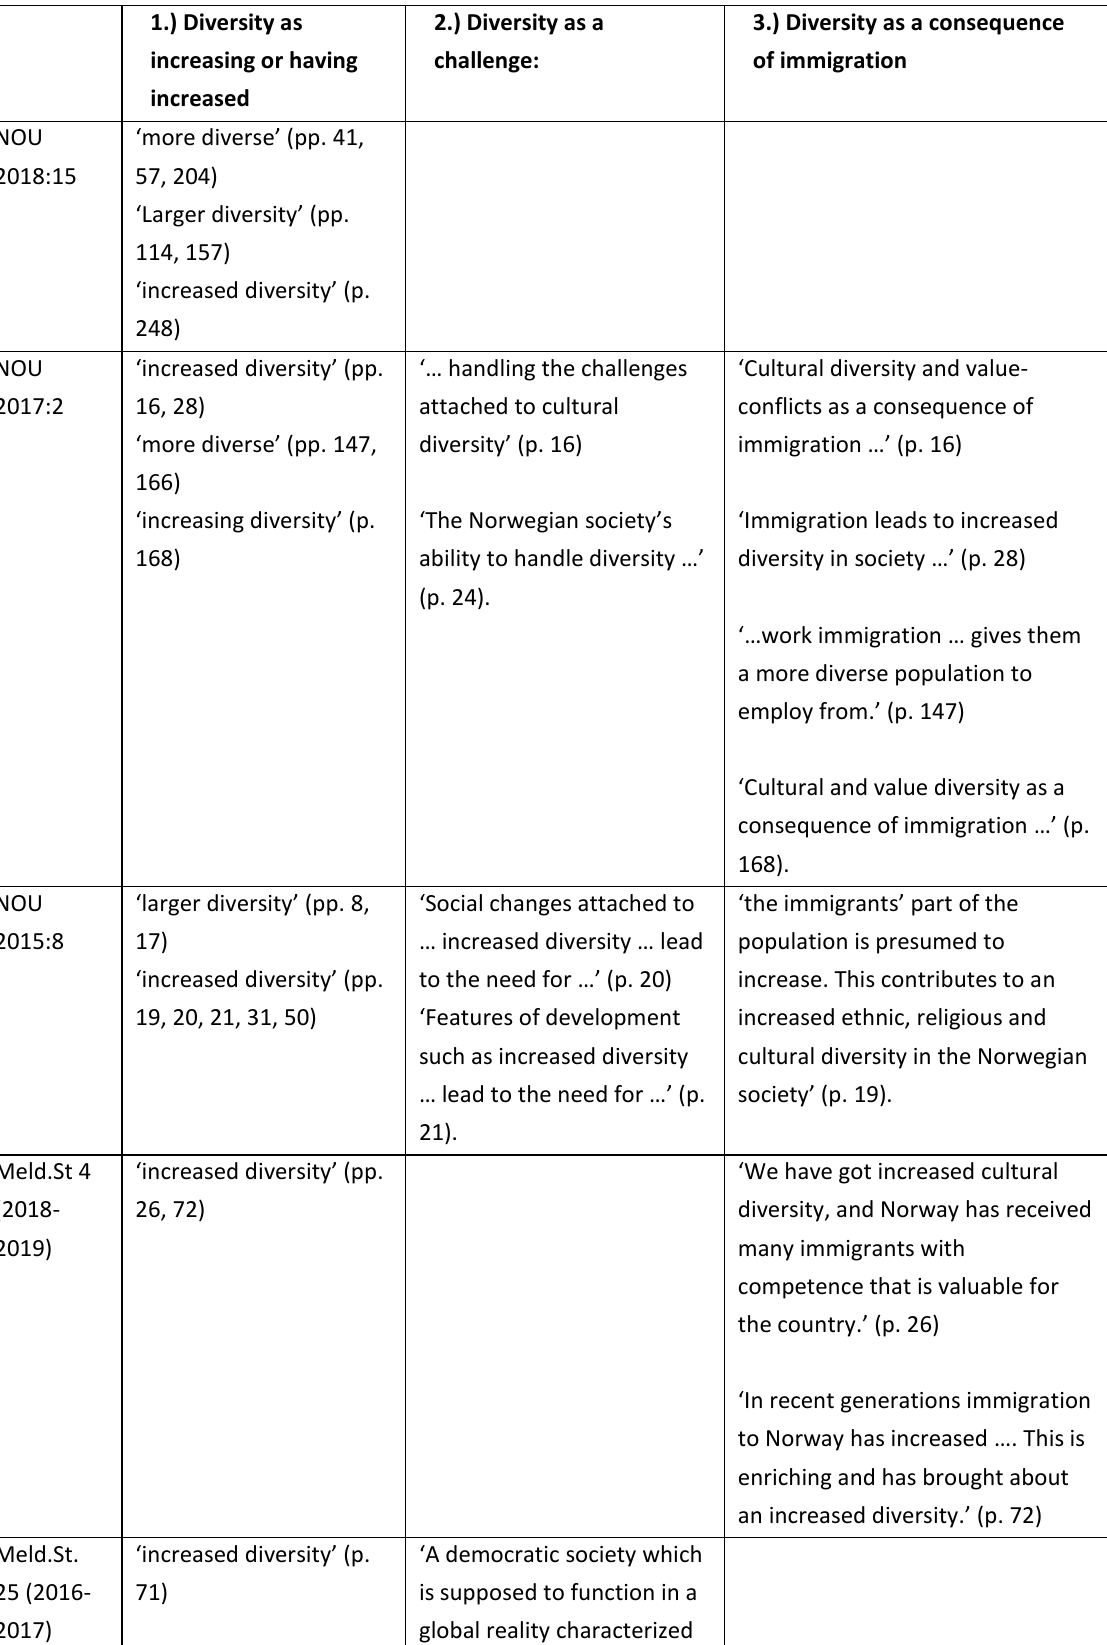
Table 1 Occurrences of diversity/diverse in eight education policy